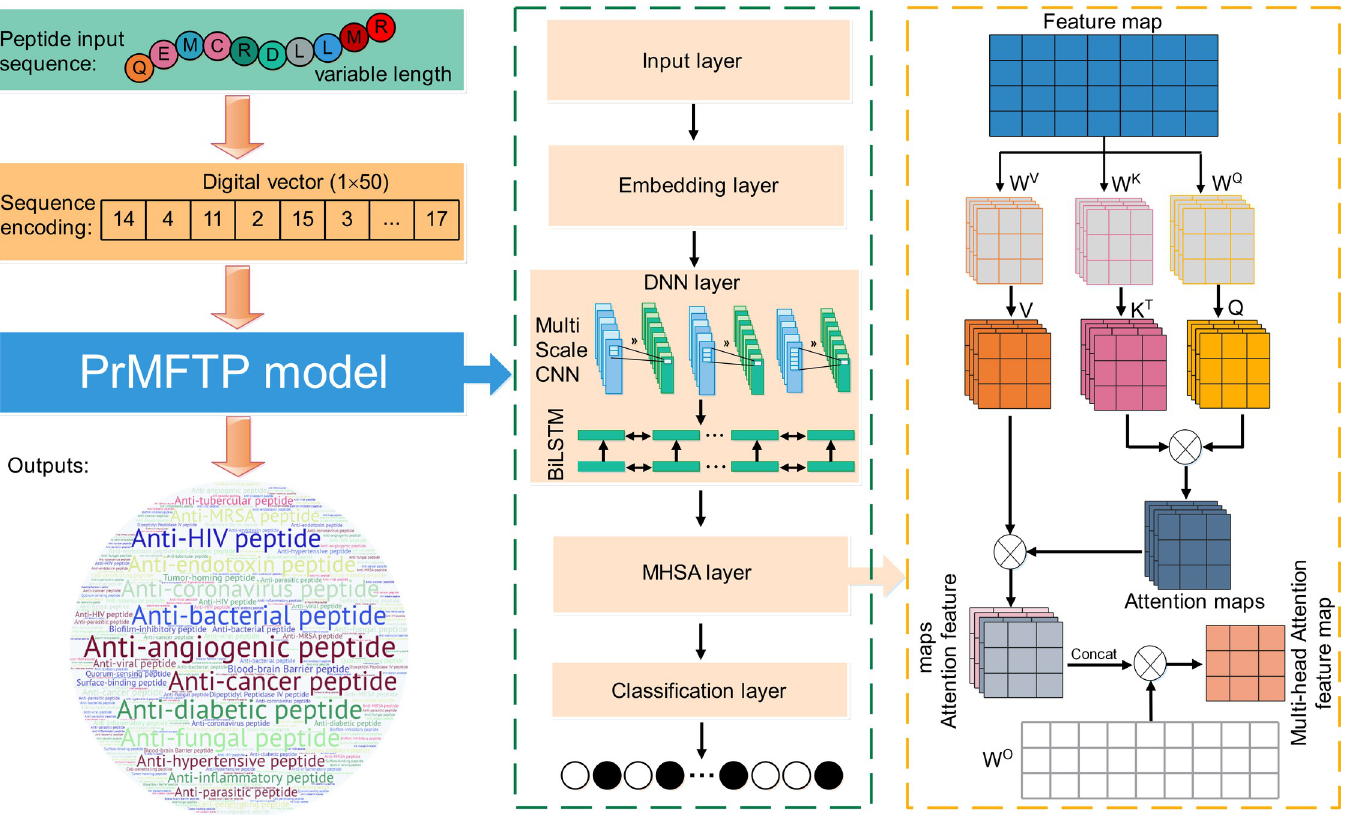
Fig 1. The framework of PrMFTP. First, peptide sequences are encoded as an input vector using numbers, and converted into a fixed-size matrix through the embedding layer. Second, DNN layer, a combination of multi-scale CNN and BiLSTM architectures, is used to capture the sequence features. Third, multi-head self-attention mechanism (MSHA) is used to make the model attend the more important and discriminating sequence features for prediction of multi-functional therapeutic peptides. Finally, the resulting feature matrix is fed into a classification layer and applied to score the different therapeutic peptides to achieve the predicted